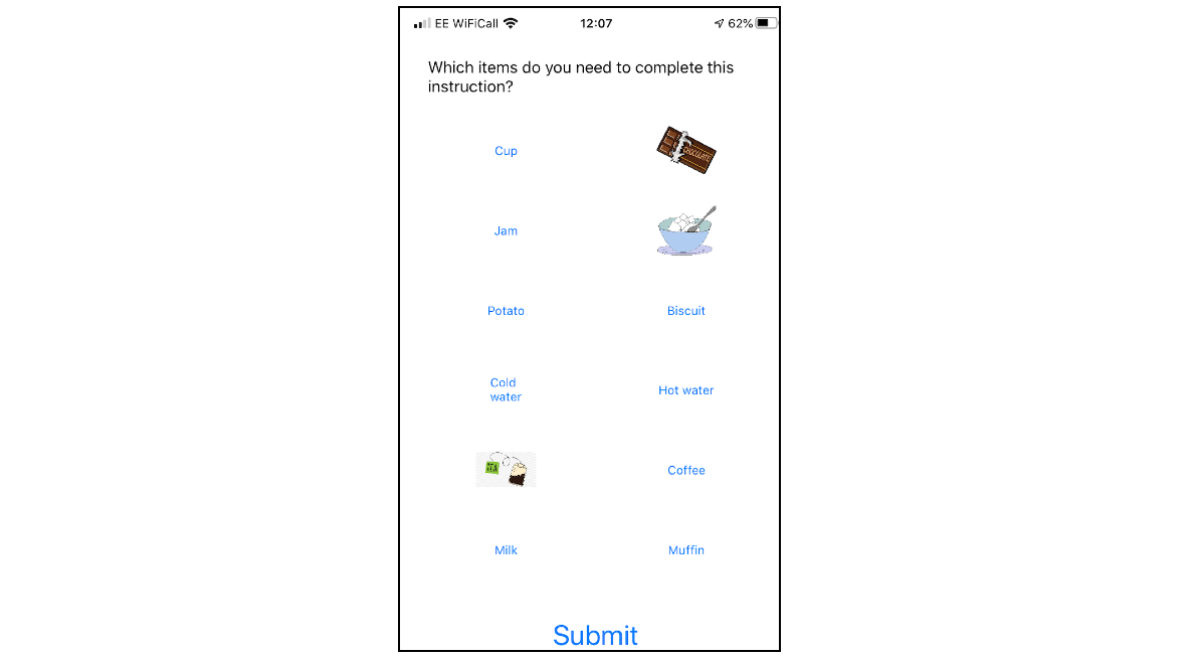
Figure 2. Screen where the user chooses the items that are needed to execute the audio